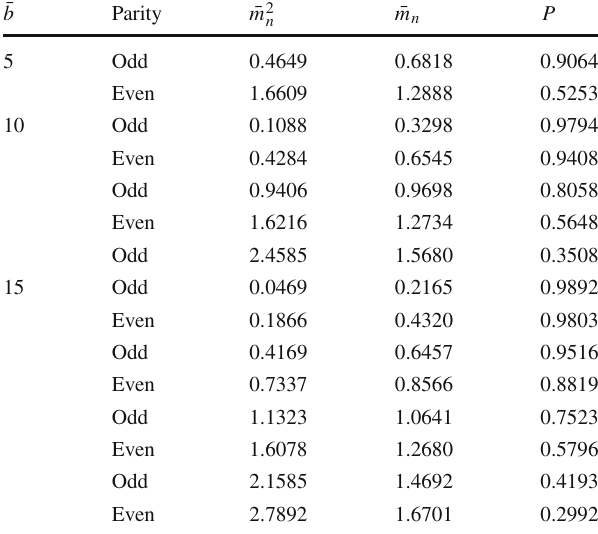
Table 1 Resonant mass spectrum ¯ m 2 n , ¯ m n , and relative probability P for different values of the parameter ¯